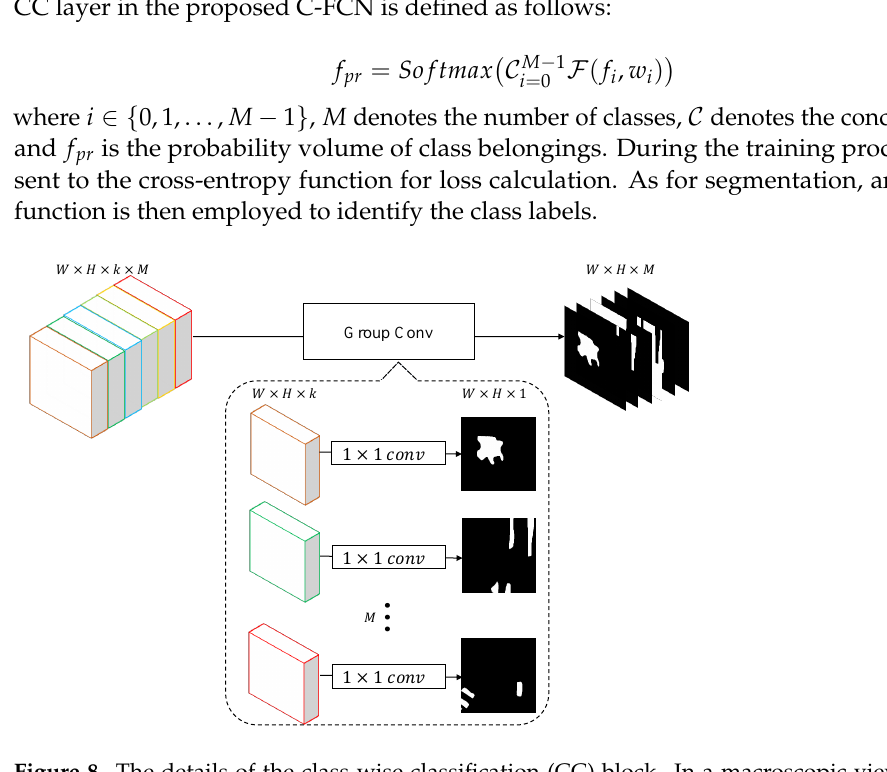
Figure 8. The details of the class-wise classification (CC) block. In a macroscopic view, a group convolution layer with kernel size 1 × 1 is applied to categorize the input feature map. Implicitly, it can be regarded that M binary classifiers are working